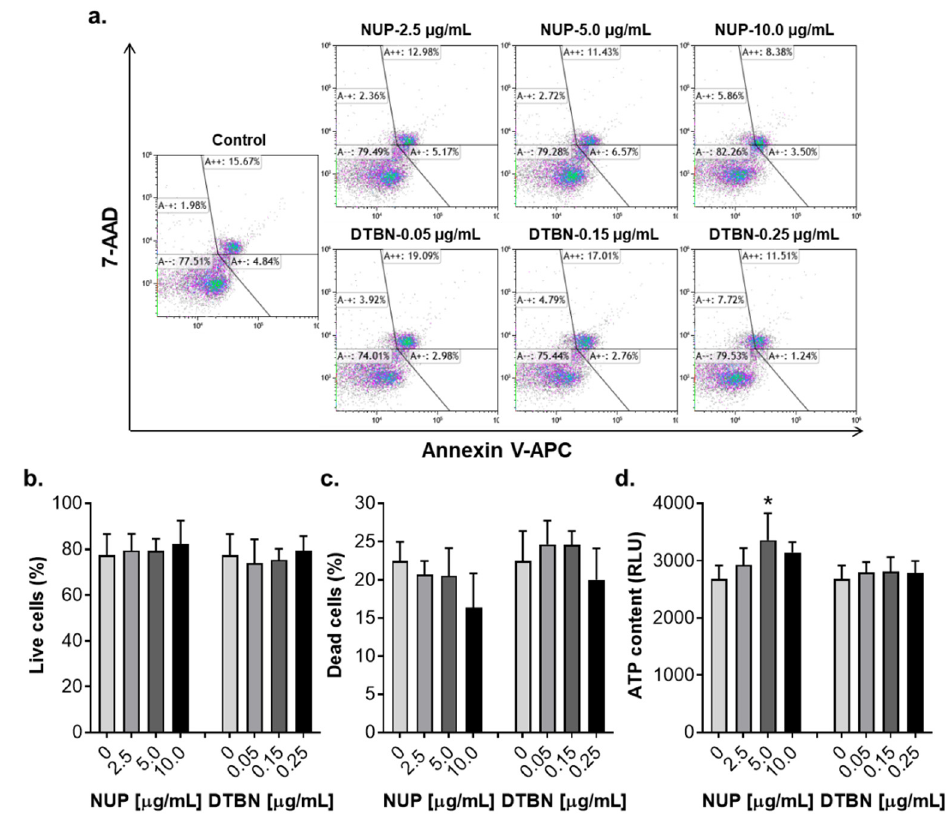
Figure 12. Effects of NUP and 6,6 ′ -dihydroxythiobinupharidine (DTBN) on cell death and viability of normal human peripheral blood mononuclear cells (PBMC). Cells (1.5 × 10 5 /mL) were incubated with the indicated concentrations of NUP or DTBN for 24 h. The extent of cell death and viability was measured by the annexin-V/PI assay and the ATP assay, respectively. ( a ) Typical flow cytometric data from a representative experiment. ( b ) Averaged percentages of live (annexin-V/PI double-negative) cells. ( c ) Averaged percentages of dead (annexin-V only-positive plus PI only-positive plus annexin-V/PI double-positive) cells. ( d ) Changes in cell viability measured on the basis of a relative cellular ATP content. The data are means ± SD of 3 independent experiments performed in duplicate ( b , c ) or quadruplicate ( d ). *, p < 0.001, vs. vehicle-treated (control) cells.